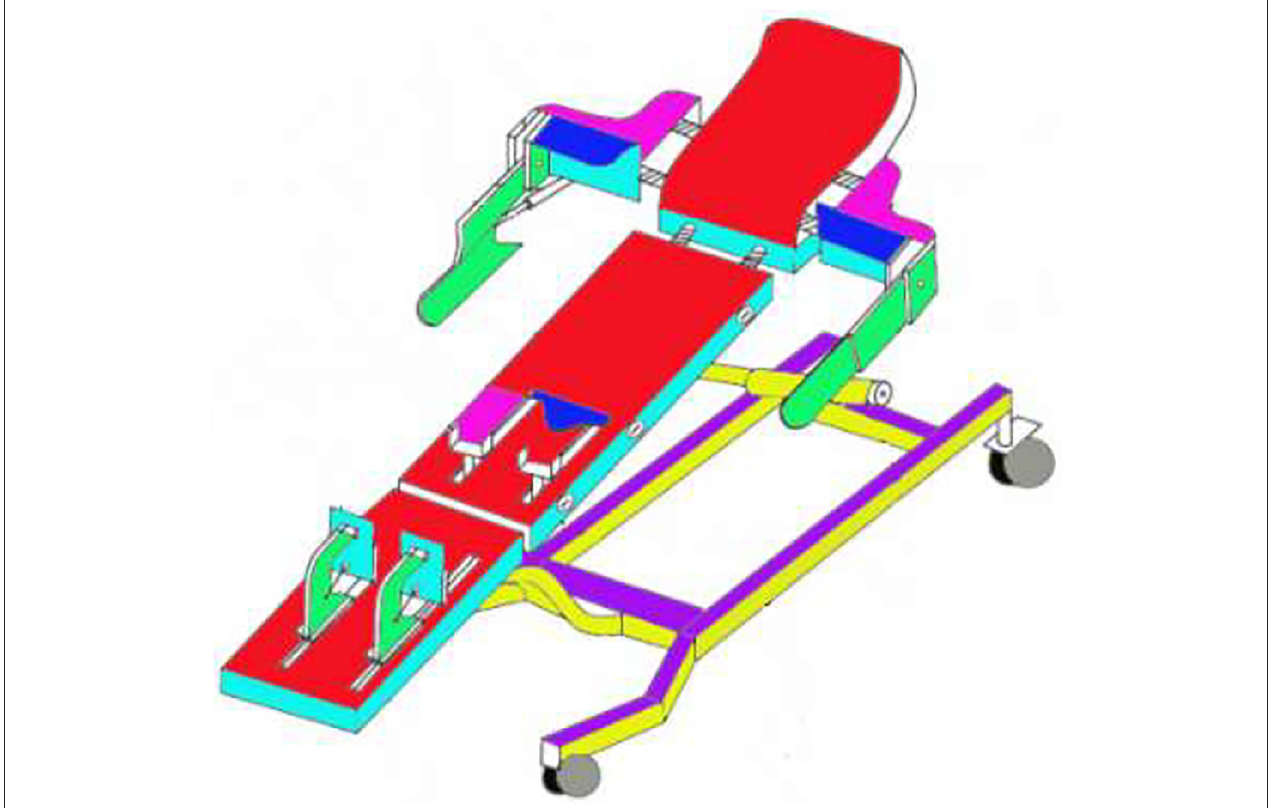
FIGURE 5 | Schematic diagram of the human–machine coordinated motion experiment